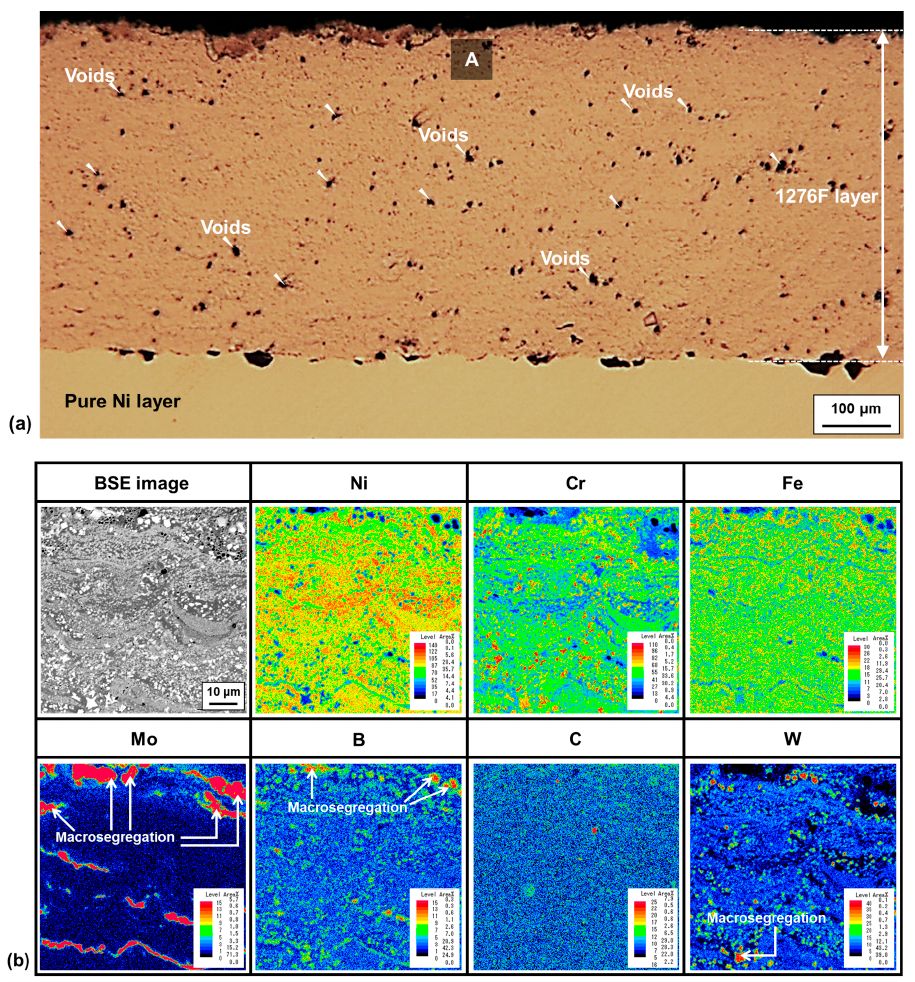
Figure 4. ( a ) Macrostructure and ( b ) element distribution obtained by EPMA analysis (from “A” region in Figure 4a) of the thermal-sprayed layer of the as-sprayed specimen.